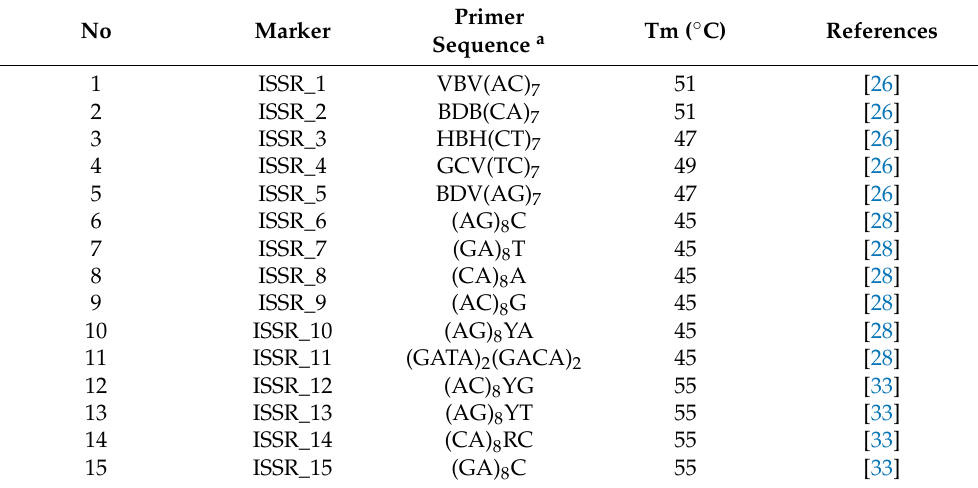
Table 2. List of ISSR markers used in this study for screening the six strawberry accessions. No Marker